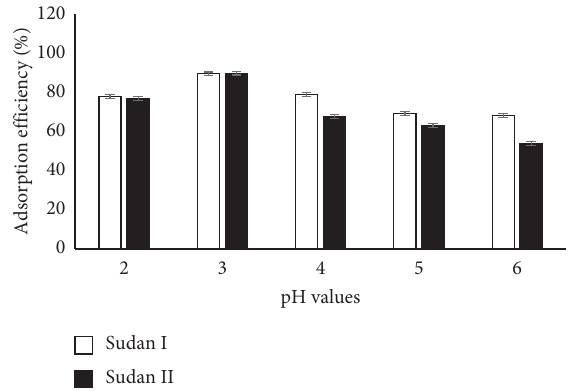
Figure 6: Effect of pH on dye adsorption efficiency at pH